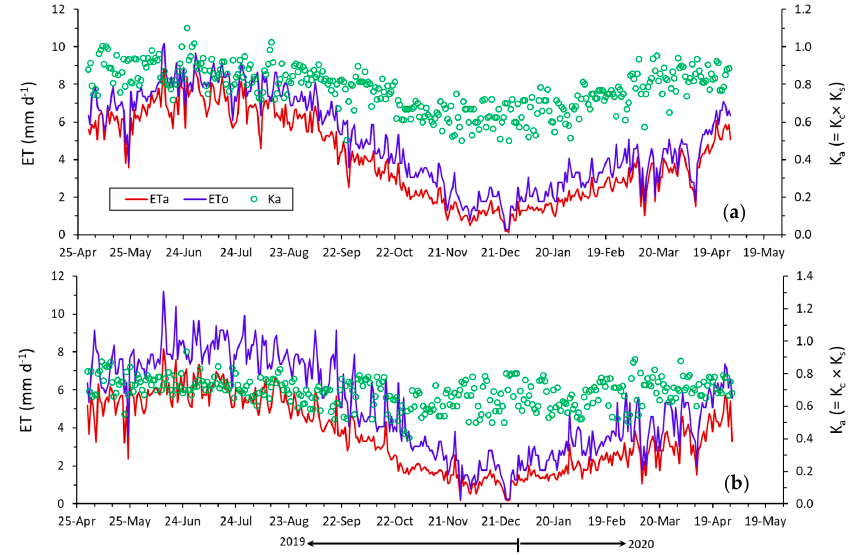
Figure 11. Daily reference evapotranspiration (ET o ), actual evapotranspiration (ET a ), and actual crop coefficient (K a ) at ( a ) the DP3 experimental site and ( b ) site DP5. The results are presented for the 12-